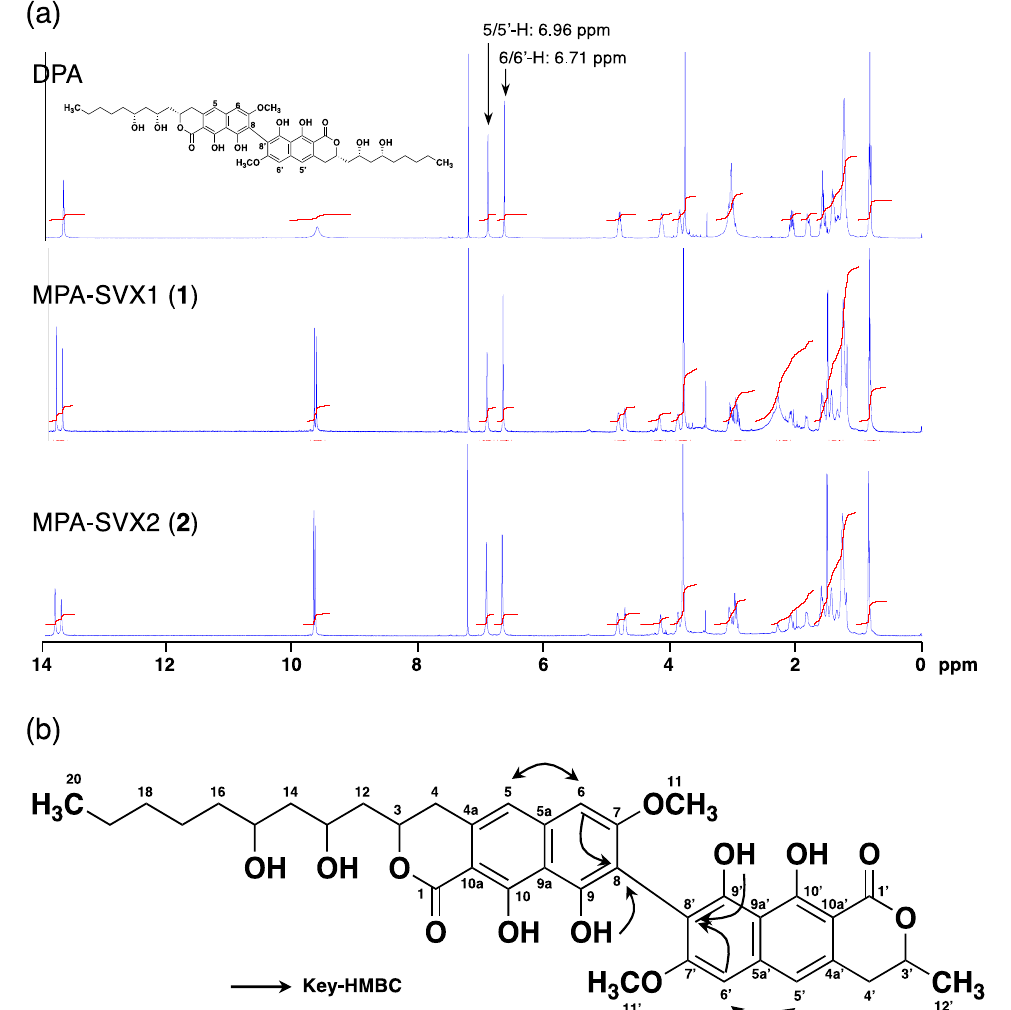
Figure 4. Structural analysis of MPA ‐ SVX. ( a ) 1 H NMR spectra of DPA, MPA ‐ SVX1 and MPA ‐ SVX2 in CDCl 3 . Chemical shifts are shown with reference to CDCl 3 at 7.26 ppm. ( b ) HMBC analysis of MPA ‐ SVX1 and MPA ‐ SVX2.